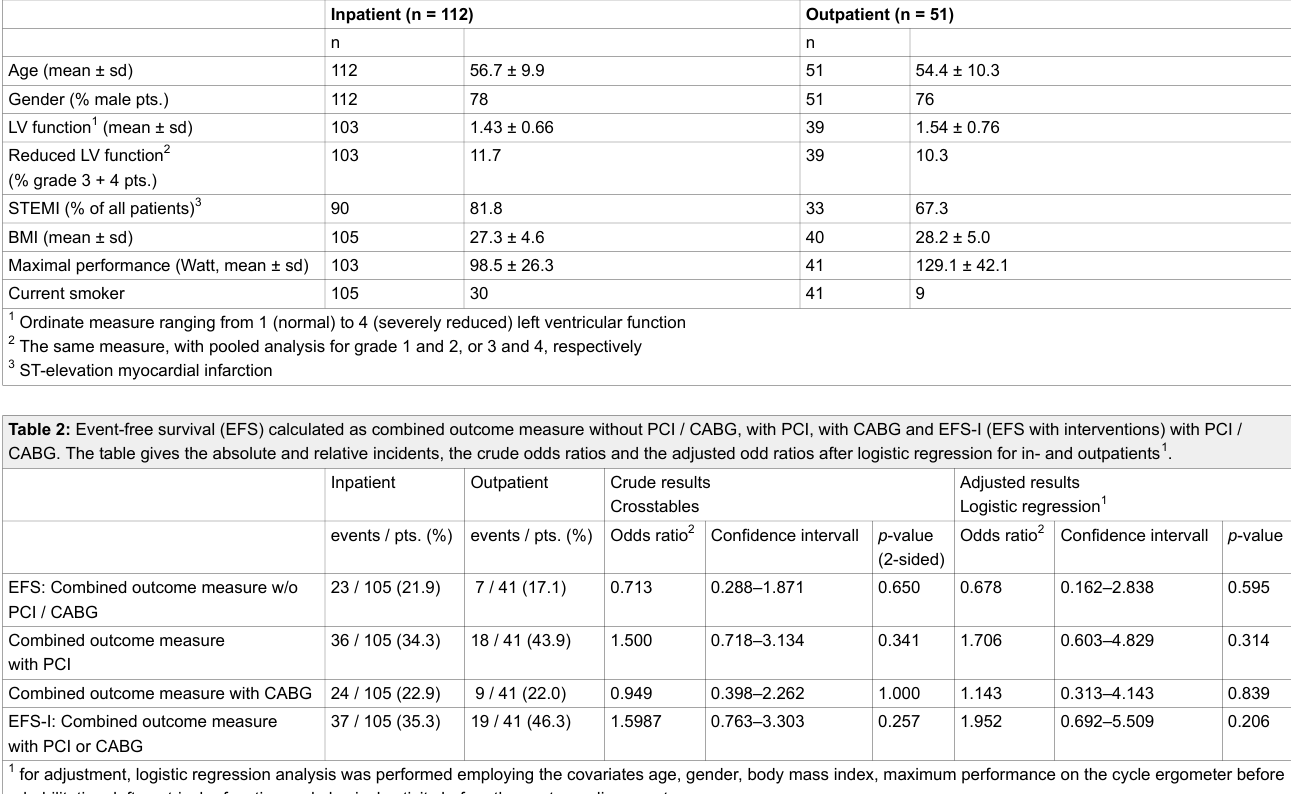
Table 1: Baseline characteristics of study sample (n = 163).